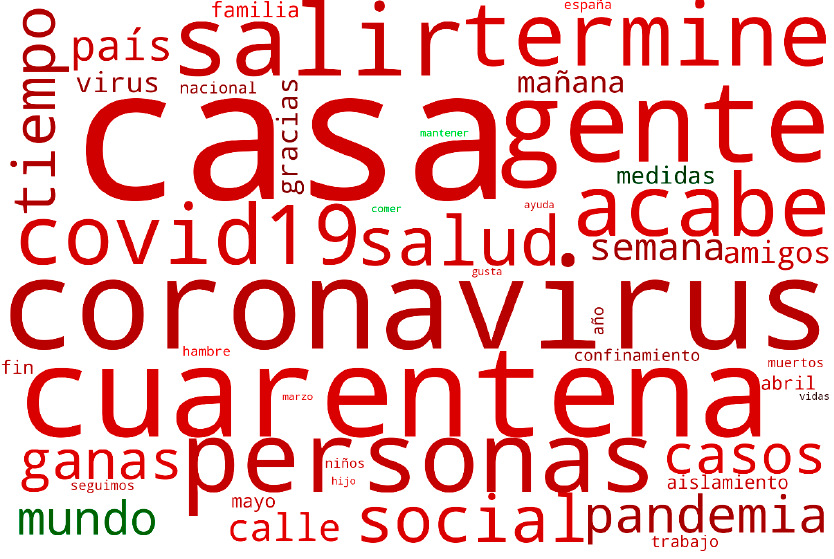
Figure 3. Word-cloud representing the word frequency and emotion polarity.